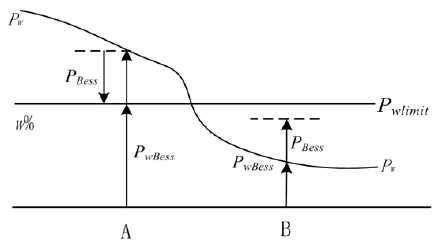
Figure 1. The operation mode of the integration of the wind energy storage power station.